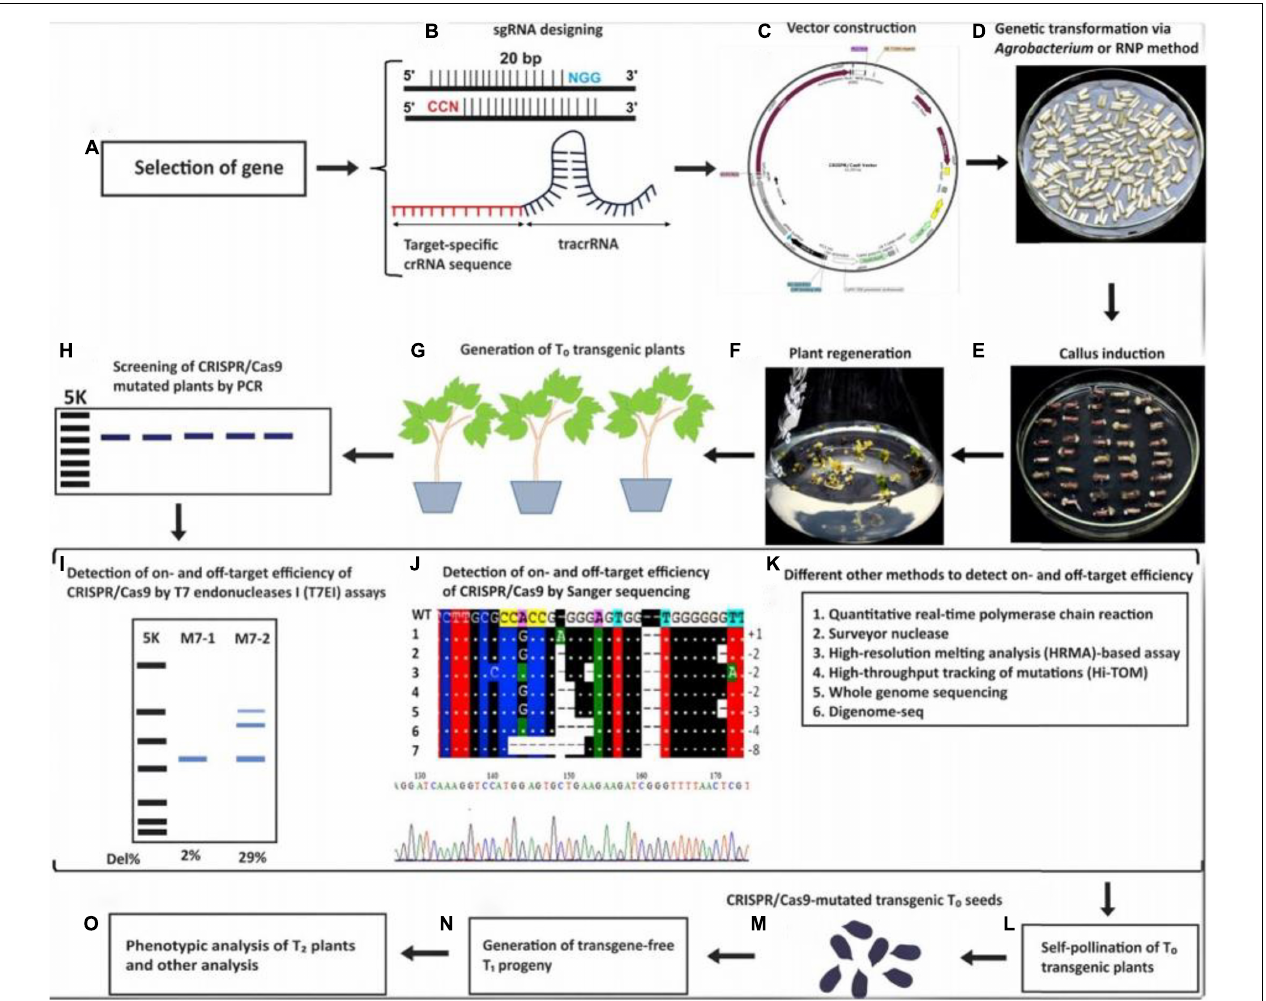
FIGURE 2 | Schematic illustration of the steps involved in CRISPR/Cas9 Genetic Transformation; (A) Specific gene selection, (B) sgRNA designing for the specific gene, (C) vector construction, (D) transformation of the CRISPR/Cas9 system via Agrobacterium, (E) callus induction from agrobacterium infected explants, (F) plant regeneration from callus, (G) T 0 CRISPR/Cas9 mutated transgenic plants, (H) screening of transgenic plants by PCR, (I) identification of mutated plants by T7E1, (J) detection of transgenics by sanger sequencing, (K) various techniques to detect transgenic plants, (L) self-pollination of T 0 transgenic plants for generation of homozygous T1 plants, (M) mutated T 0 seeds, (N) Generation of transgene- free T 1 progeny, (O) Phenotypic analysis of T 1 plants. Reproduced with permission from Manghwar et al. (2019)